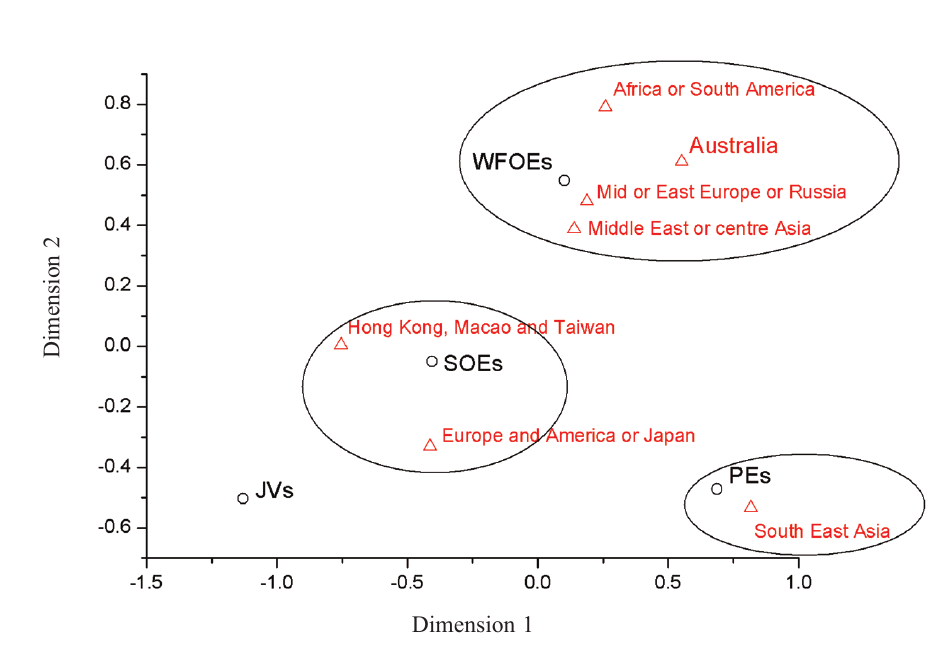
Fig. 4. Positioning maps between destination and enterprise